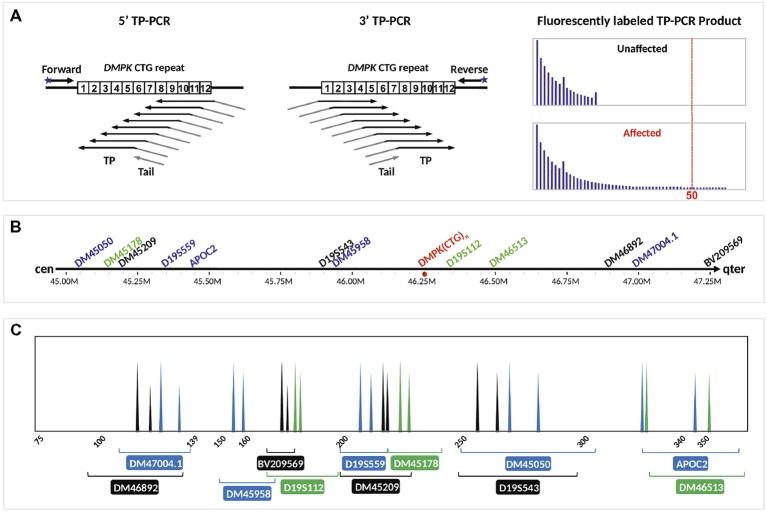
Schematic illustration of the DM1 PGT-M strategy. (A) Bidirectional 5′ and 3′ TP-PCR at the DMPK CTG repeat locus, depicting annealing positions of primers (arrows), as well as the expected electropherogram patterns from unaffected and DM1-affected embryos after capillary electrophoresis. (B) Location of 12 microsatellite markers relative to the DMPK CTG repeat. (C) Expected electropherogram results after multiplex PCR amplification of the dodecaplex marker panel and capillary electrophoresis, showing the electrophoretic peak color and approximate size range of each marker. Adapted from Lian et al. (2016, 2017).